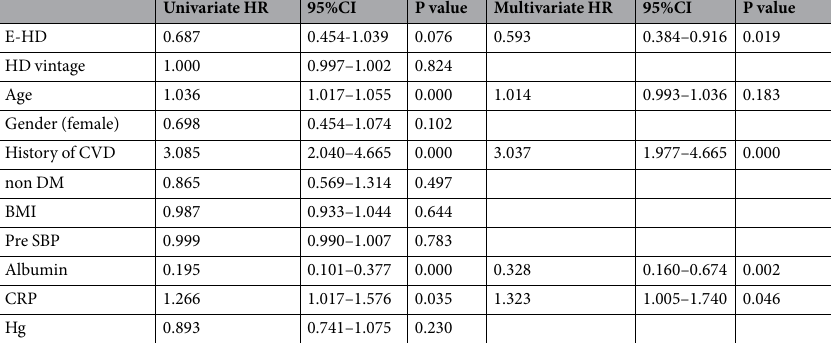
Table 4. Cox proportional hazards model analysis for the composite primary endpoints. E-HD, electrolyzed water haemodialysis; HD, haemodialysis; CVD, cardio-cerebral vascular disease; DM, diabetes mellituss; BMI, body mass index; Pre SBP, pre-dialysis systolic blood pressure; CRP, C-reactive protein; Hg,